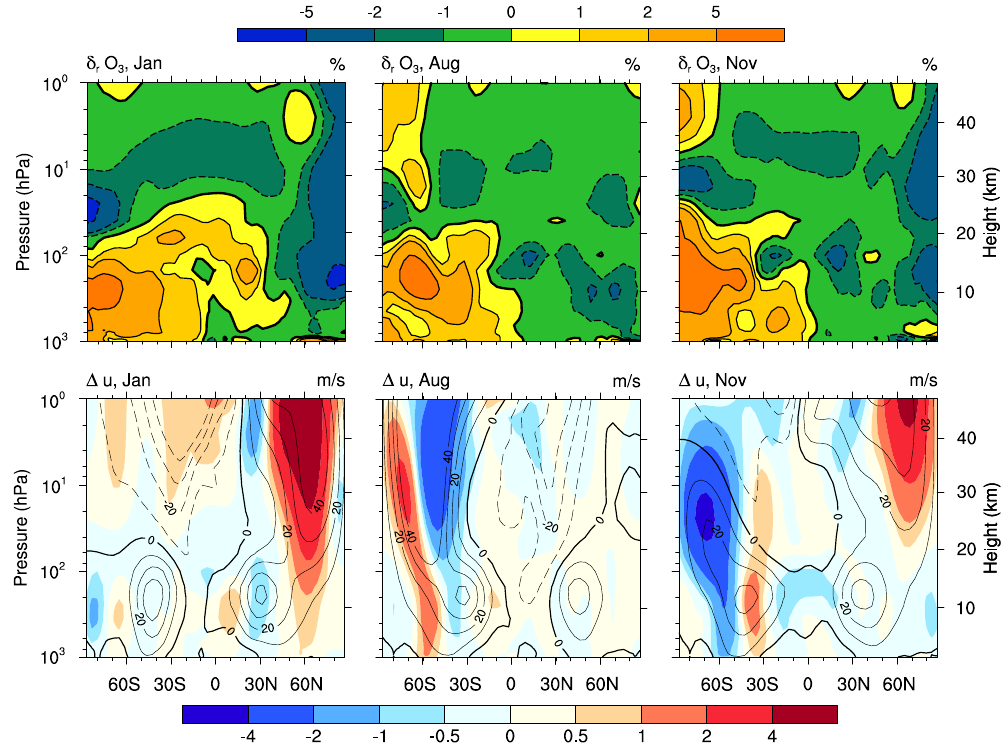
Figure 5. Simulated monthly ozone anomalies (upper panel, as in Fig. 3) and zonal winds (lower panel, as in Fig. 4). Results are shown for simulation